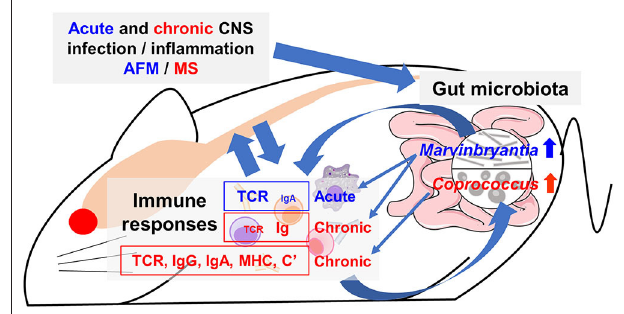
FIGURE 10 | Working hypothesis of communication between the CNS and gut microbiota mediated by immune system. Acute or chronic CNS infection TMEV results in inflammation of the gray matter or white matter of the spinal cord, leading to diseases mimic acute flaccid myelitis (AFM) or multiple sclerosis (MS), respectively. Alteration of a limited number of distinct bacteria in gut microbiota was associated with different immune gene expressions during the acute and chronic phases. The genus Marvinbryantia abundance correlated with gene expressions of distinct T-cell receptors (TCR) and immunoglobulin (Ig) A during the acute phase and those of Igs during the chronic phase. The genus Coprococcus abundance was associated not only TCR and Ig (IgG isotypes and IgA) but also other immune related genes, including major histocompatibility complex (MHC) and complements (C’). Here, alteration of a small number of gut bacteria may affect distinct immune responses and then lesions in the CNS, although we do not know the precise pathophysiology, particularly the CNS upregulation of IgA, which is a component of mucosal immunity. Alternatively, activated immune response would alter composition of gut